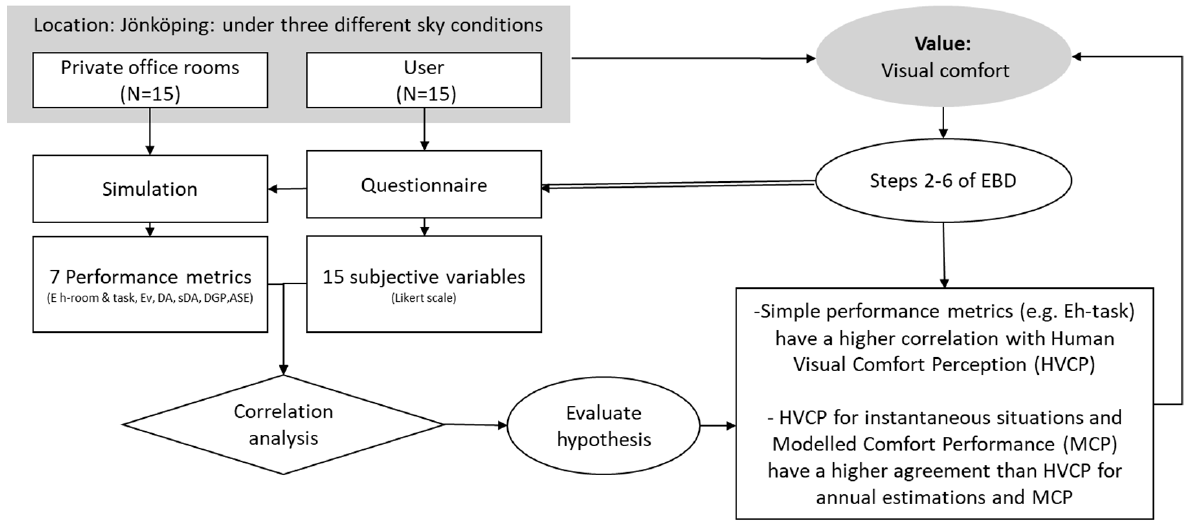
Figure 1. Study results [7] implementation in the EBD-SIM model addressing the workflow during the post-occupancy evaluation steps.